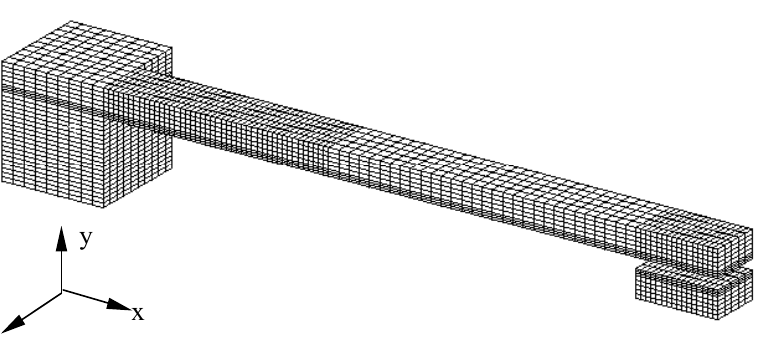
Figure 3. Typical finite element